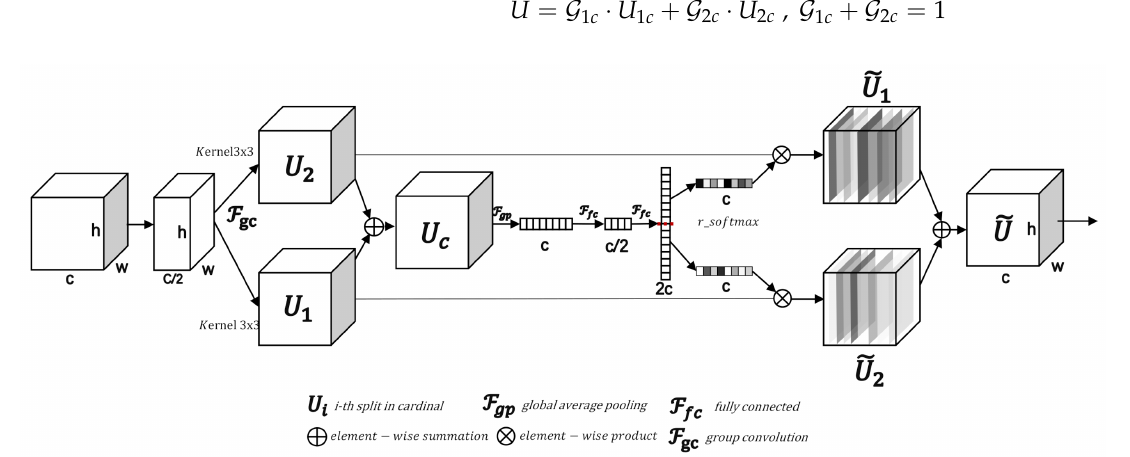
Figure 2. Split-attention module with the cardinality parameter set to 1 and the radix parameter set to 2.